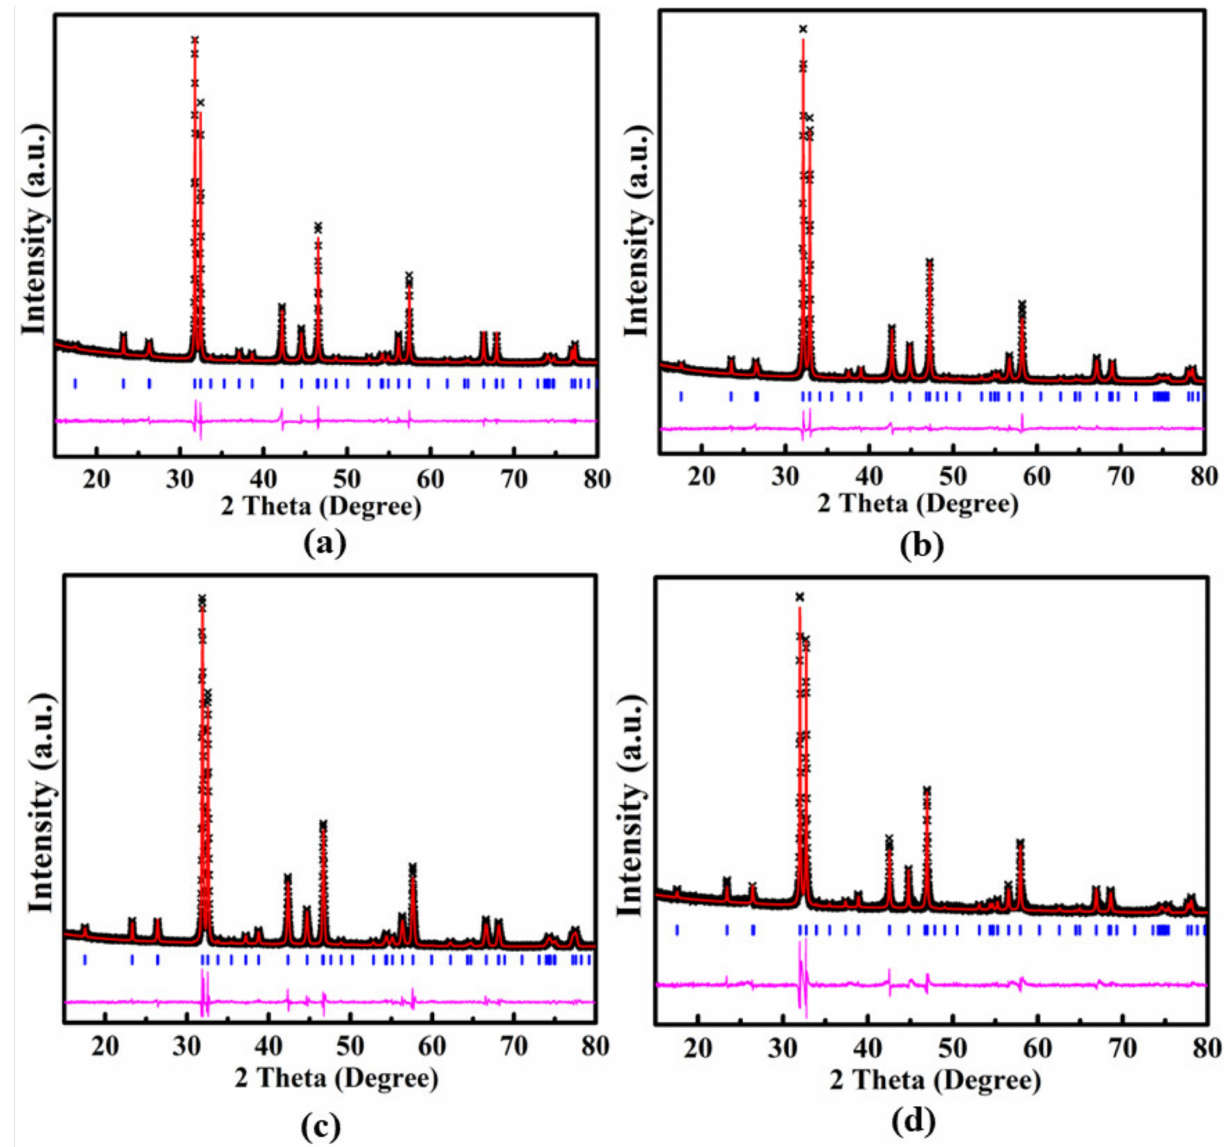
Figure 2. Rietveld refinement profiles with powder X-ray diffraction data for ( a ) Sr 3 Ti 2 O 7 , ( b ) Sr 3 TiMnO 7 , ( c ) Sr 3 TiFeO 7 − δ , and ( d ) Sr 3 TiCoO 7 − δ . The experimental data are represented by black crosses. The red line shows the fit. The vertical blue tick marks and the lower pink line correspond to the Bragg peak positions and difference plot,